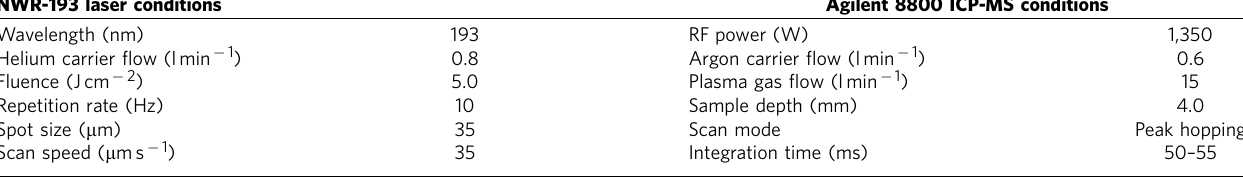
Table 2 | LA-ICP-MS operating